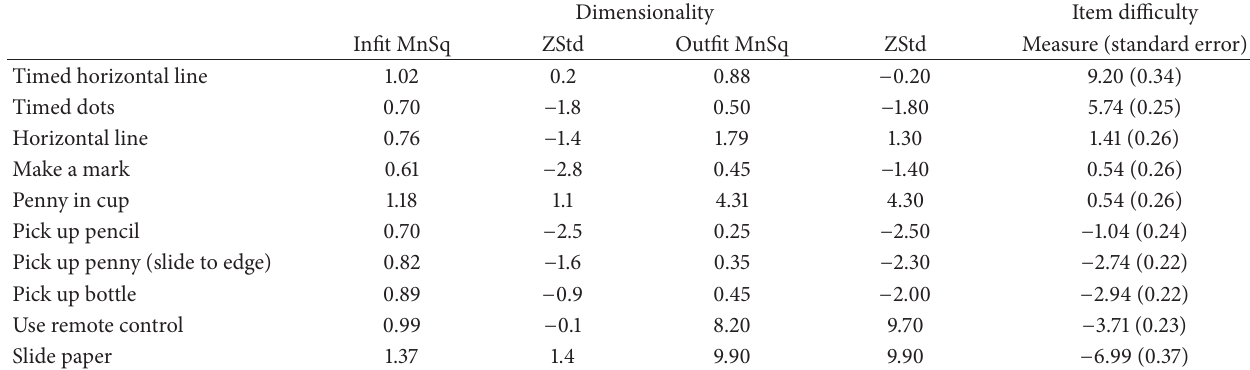
Table 2: Behavioral criteria statistics for hand activities